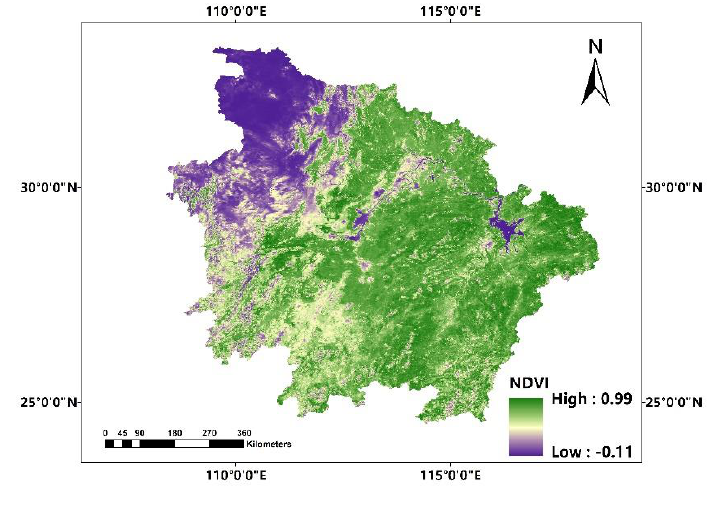
Figure 9. Figure 9. NDVI. Figure 9. NDVI.